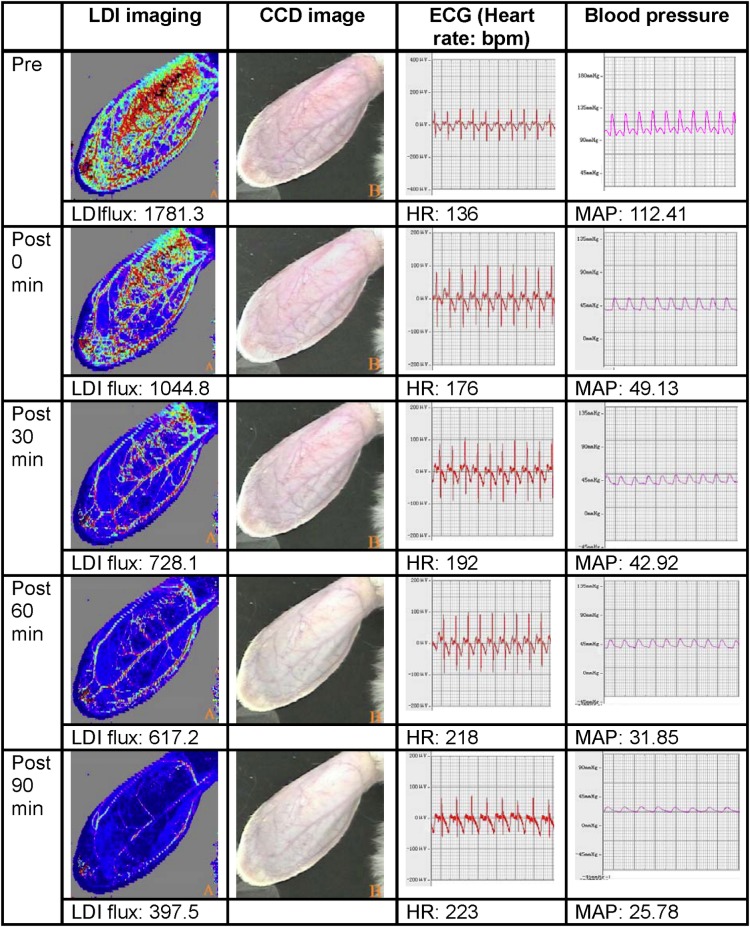
Top-to-bottom LDI scans of a typical rabbit ear at different time points.Lighter shades correspond to higher perfusion in flux units and darker areas correspond to lower perfusion. A mean flux value was obtained for each image.